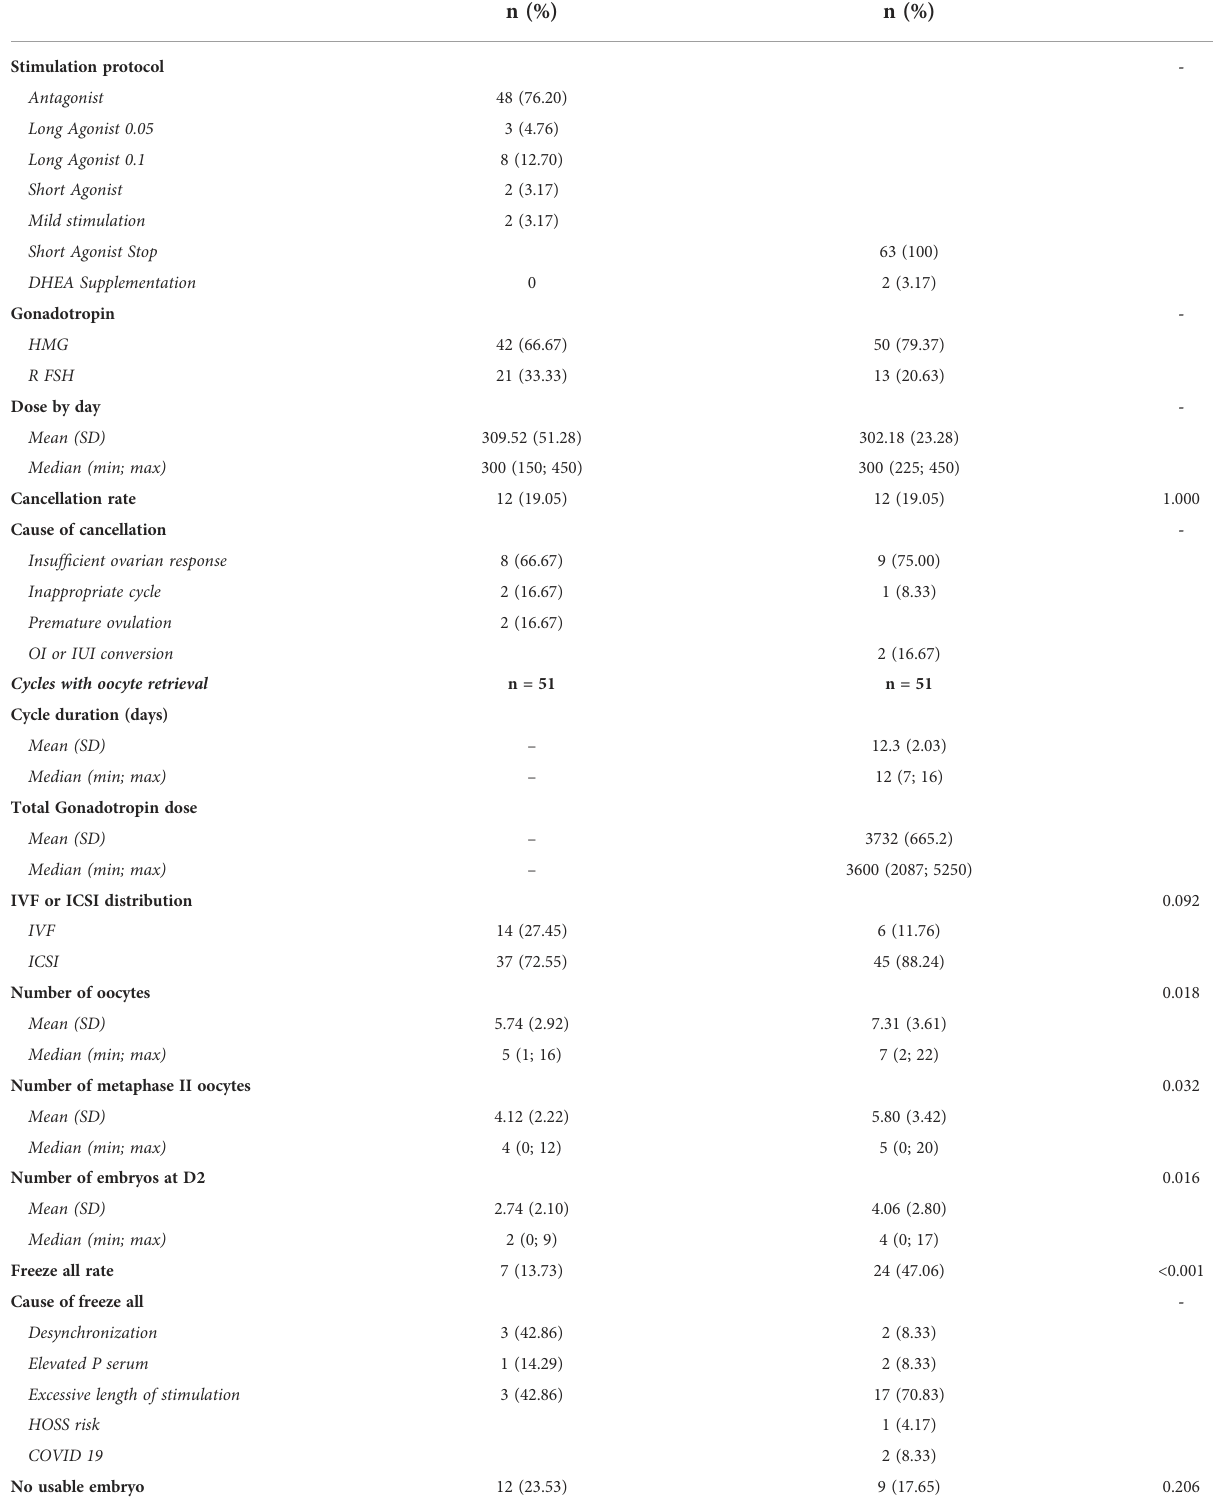
TABLE 2 Controlled ovarian stimulation and IVF cycle